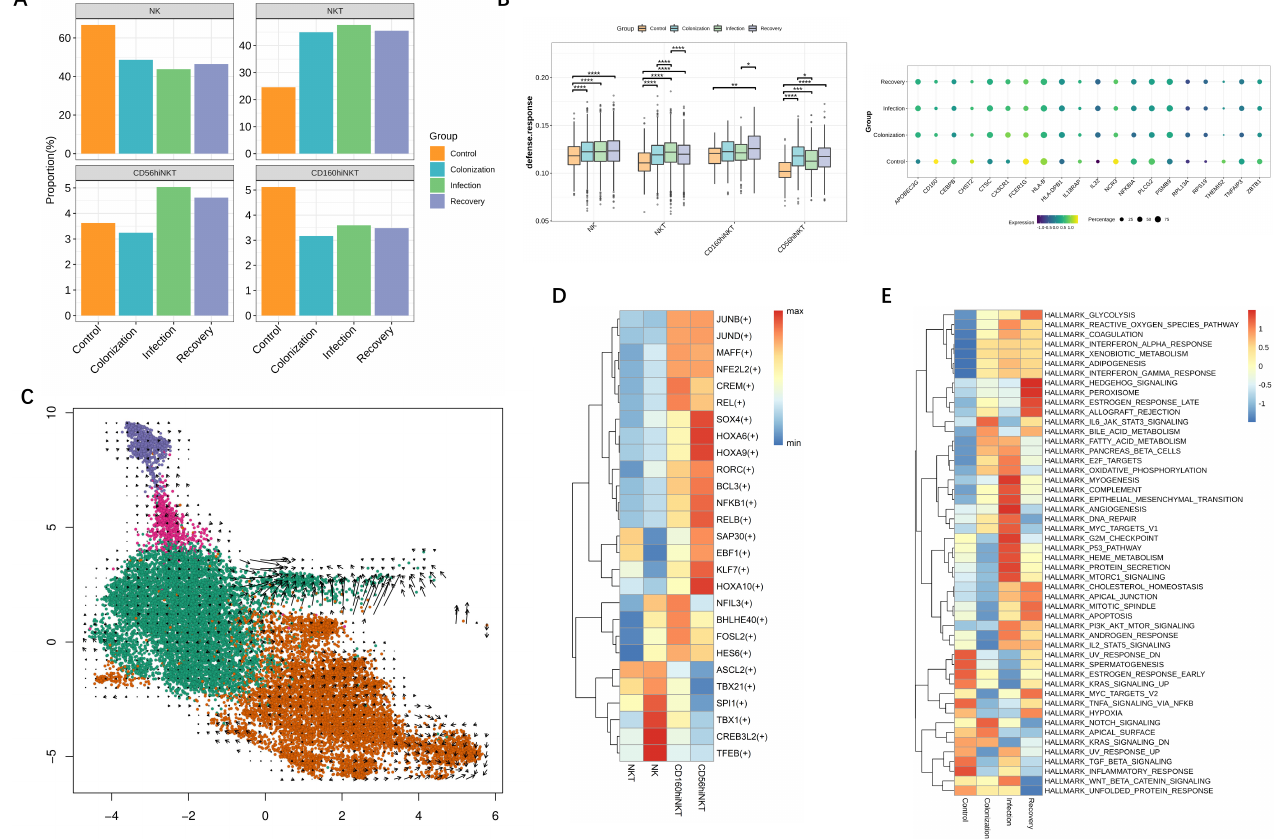
Figure 2. Circulating NK and NKT subset states during CRKP infection. ( A ) The cell type proportions across conditions. ( B ) Box plots of the response defense score across conditions. Conditions are shown in different colors. Horizontal lines represent median values; * p < 0.05; ** p < 0.01; *** p < 0.001; **** p < 0.0001; two-sided unpaired Dunn’s (Bonferroni) test. Dot plot showing expression of some genes associated with antibacterial response across conditions. The circle size and color, respectively, indicating the percentage and expression levels of cells expressing pathway-associated genes under each condition. ( C ) Potential developmental trajectory of NK and NKT clusters analyzed by RNA velocity. ( D ) TF analysis indicating the predicted regulators of each immune cell types. ( E ) GSVA analysis indicating the enriched Molecular Signatures Database hallmark gene sets of NK cluster across